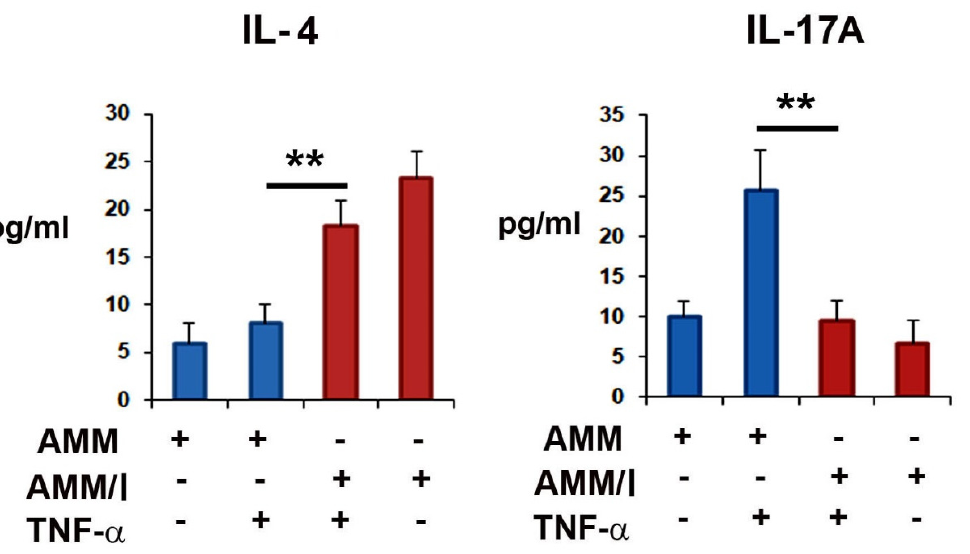
Figure 1. Immunomodulatory potential of interleukin (IL)-10-overexpressing amniotic mesenchymal stem cells (AMM/I) in vitro. AMMs and AMM/Id were treated or not with tumor necrosis factor (TNF)- α , and then they were co-cultured with splenocytes. The supernatants were collected and the concentrations of IL-10 and IL-17A were measured via enzyme-linked immunosorbent assay (ELISA) (n = 5 each; ** p <